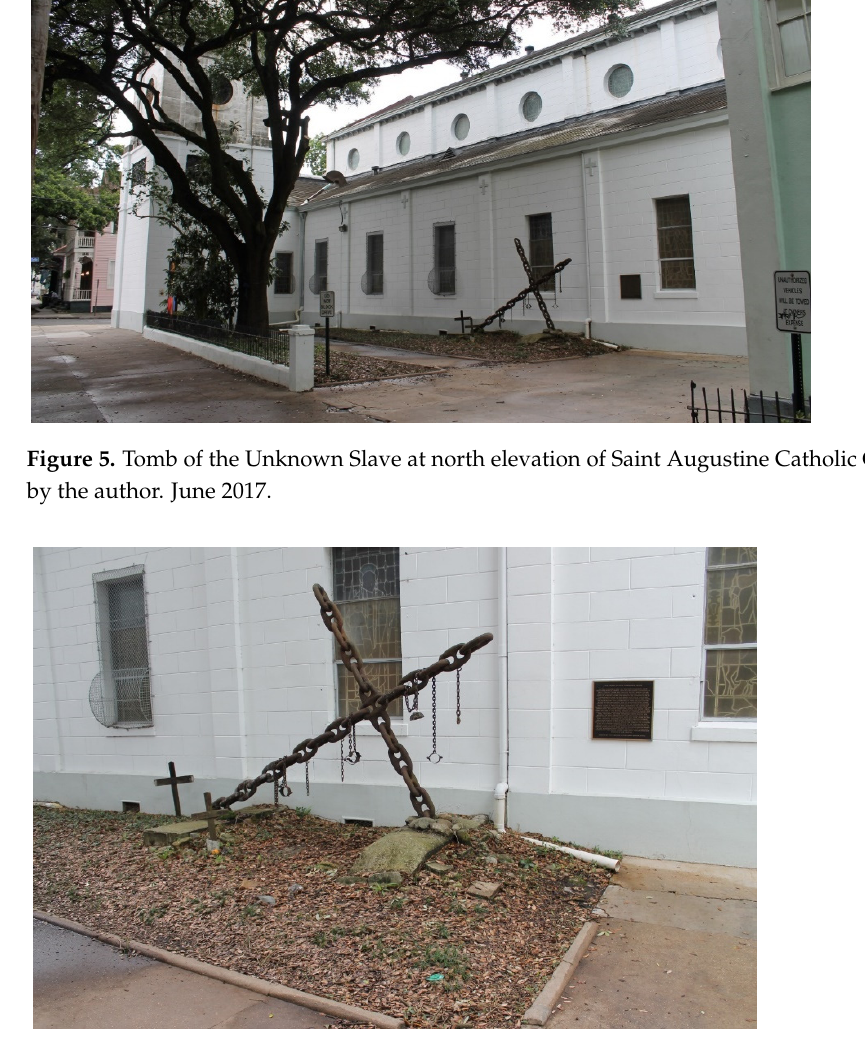
Figure 6. The Tomb of the Unknown Slave Monument makes a cross of steel links with shackles hanging from the cross. Image by the author. June 2017.